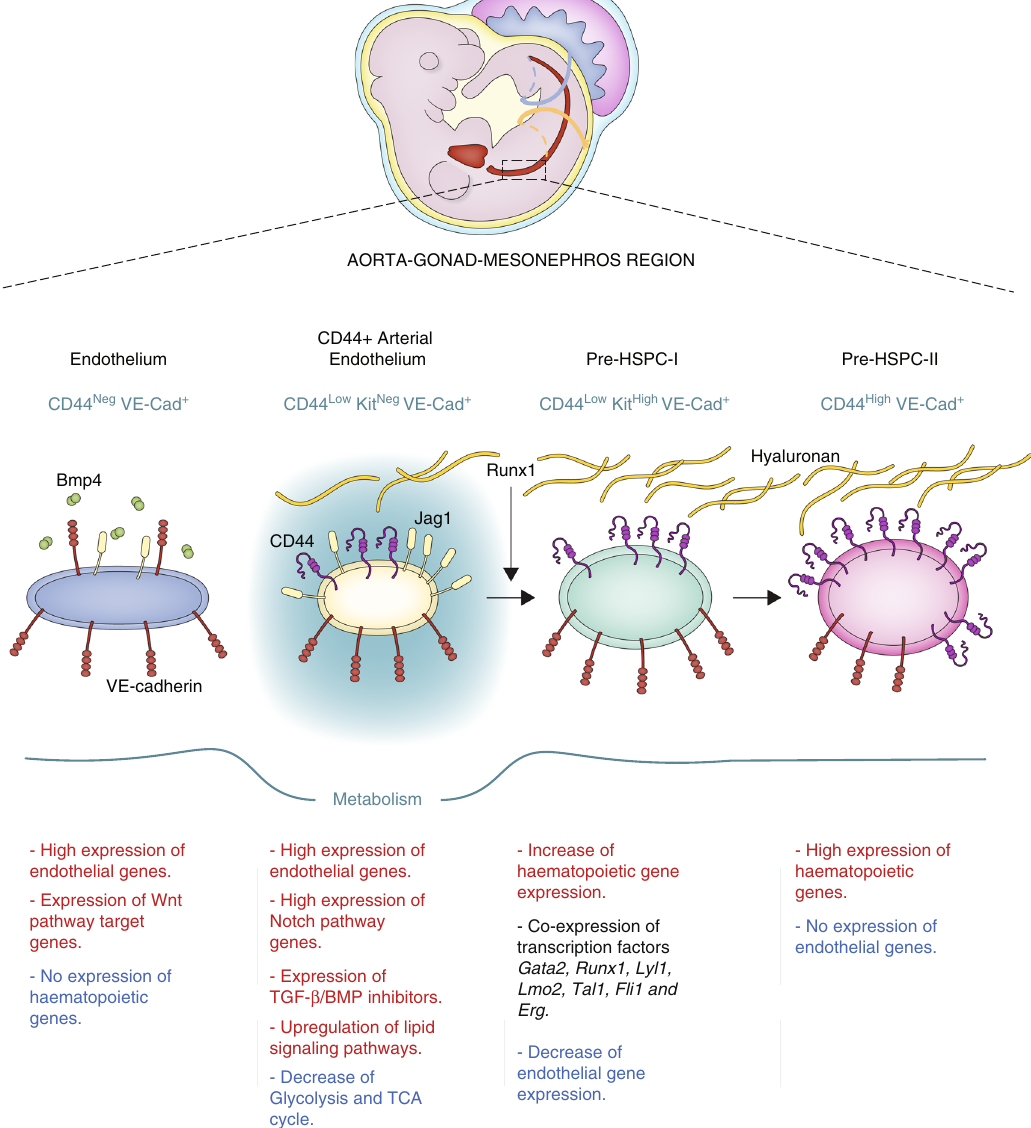
Fig. 10 New model for the progression of EHT. Scheme summarising the fi ndings of the present study. We identi fi ed two different sets of endothelial cell populations in the AGM with very distinct properties in term of signalling pathways and metabolic states. Expression of Runx1 in the CD44 + arterial endothelial population triggers the upregulation of haematopoietic genes and the formation of the Pre-HSPC-I, which co-expresses endothelial and haematopoietic genes. Continuous expression of haematopoietic genes and interaction between CD44 and hyaluronan eventually lead to the loss of endothelial genes and the formation of Pre-HSPC-II expressing only haematopoietic